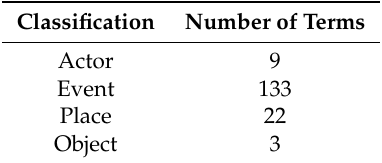
Table 4. Eurovoc criminal law term